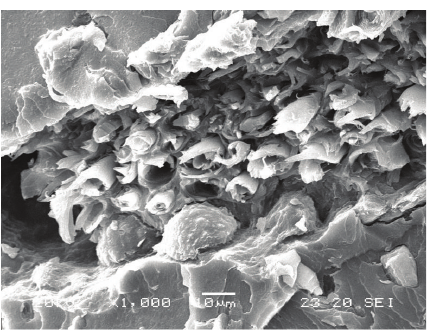
Figure 6: SEM micrograph of UPE/OPS composite with 20 vol% OPS at 1000x